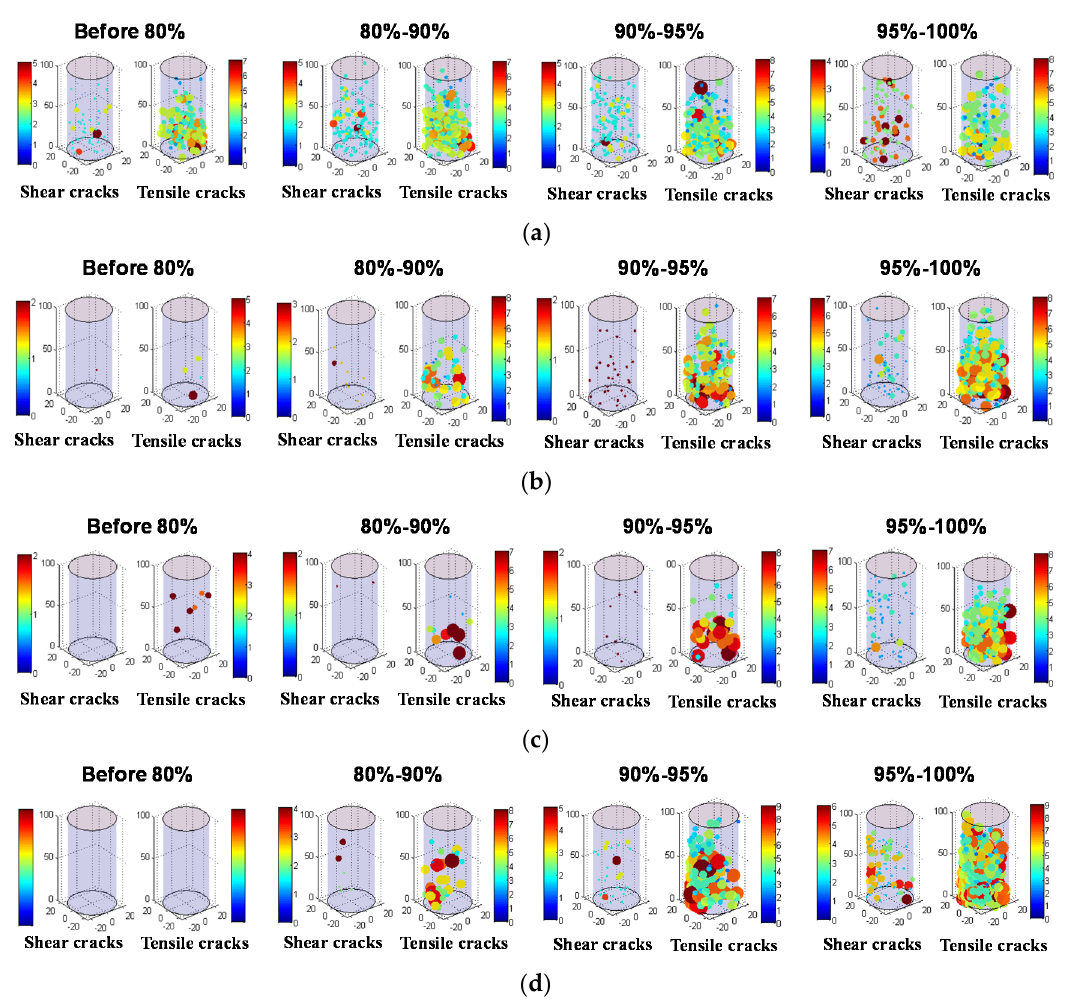
Figure 12. Spatial distribution of tensile and shear events during different stress stages of coal samples at different depths: ( a ) 300 m, ( b ) 600 m, ( c ) 850 m, and ( d ) 1050 m.